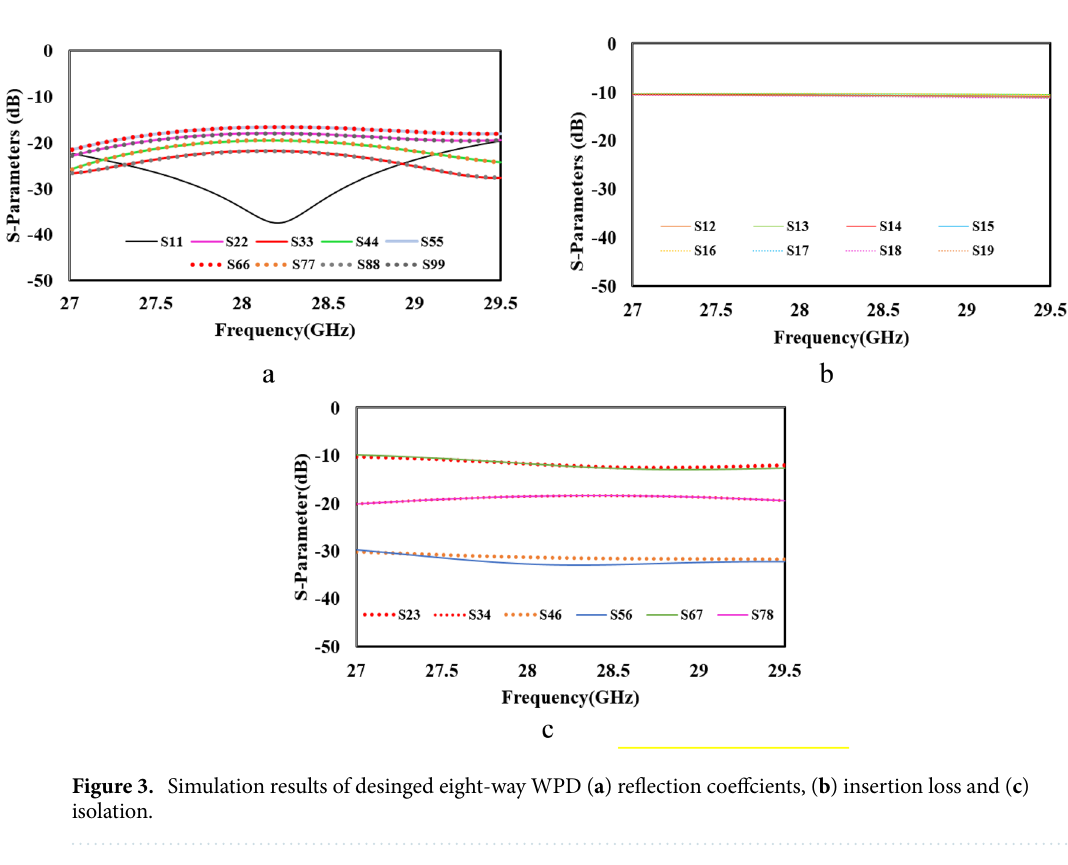
Figure 3. Simulation results of desinged eight-way WPD ( a ) reflection coeffcients, ( b ) insertion loss and ( c ) isolation.